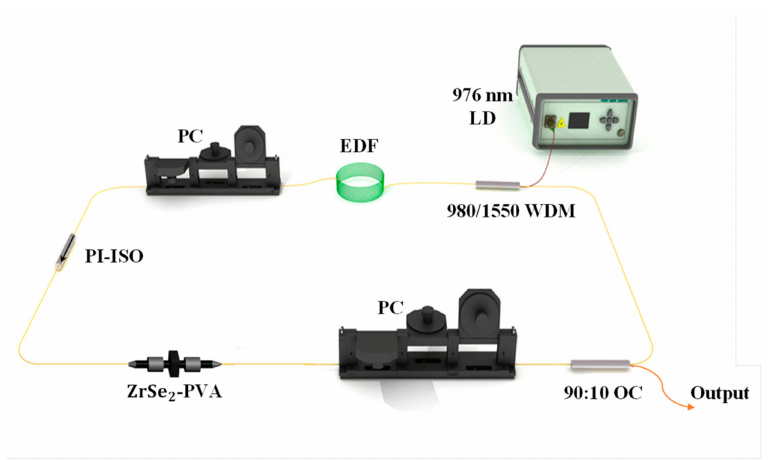
Figure 4. A schematic diagram of the experiment for the ZrSe 2 -based passively mode-locking Er-doped fiber